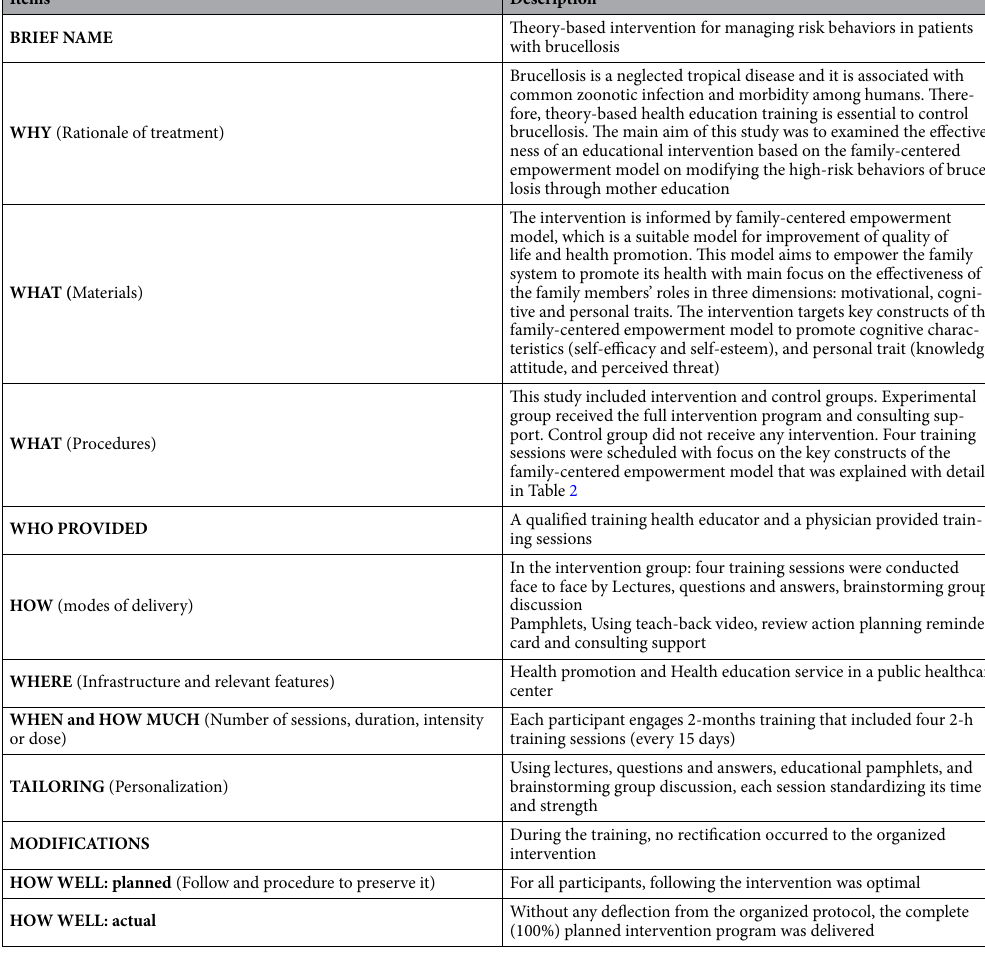
Table 1. Template for intervention description and replication checklist in this